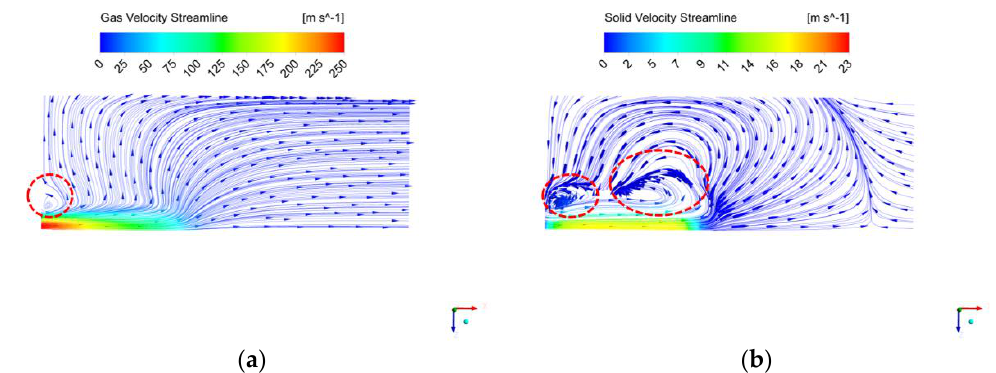
Figure 9. The tuyere level plane of Case 3 at 40 s: ( a ) gas velocity streamline; ( b ) solid velocity streamline.